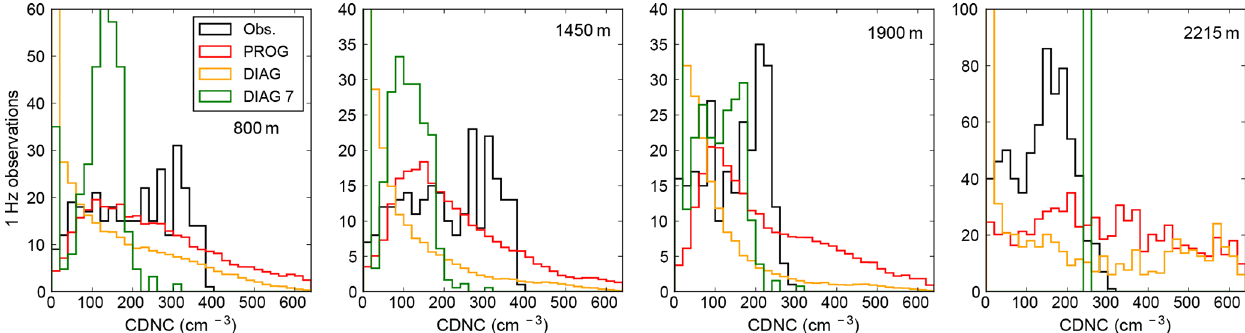
Figure 8. Cloud droplet number concentration in CLARIFY observations at 1Hz; in the 500m resolution model as predicted by ARG (PROG), labelled “PROG”; in CASIM and by ARG (DIAG) with its updraught PDF, labelled “DIAG”; and in the 7km resolution model as predicted by ARG (DIAG), labelled “DIAG 7” at altitudes of 800, 1450, 1900, and 2215m from left to right. The histograms of simulated cloud droplet number concentration are scaled to contain the same number of entries as the 1Hz observations. The histograms show droplet numbers over the full range of in-cloud liquid water contents. The observations are compared to grid boxes sampled from the whole model domain, except for the 20 grid boxes nearest the boundaries. Values are grid-box means rather than in-cloud means. Strictly, the aircraft traverses 500m in about 4s, so 1Hz is too high a sampling frequency for comparison to the model. However, down-sampling to 0.25Hz reduces the data sample without changing the shape of the